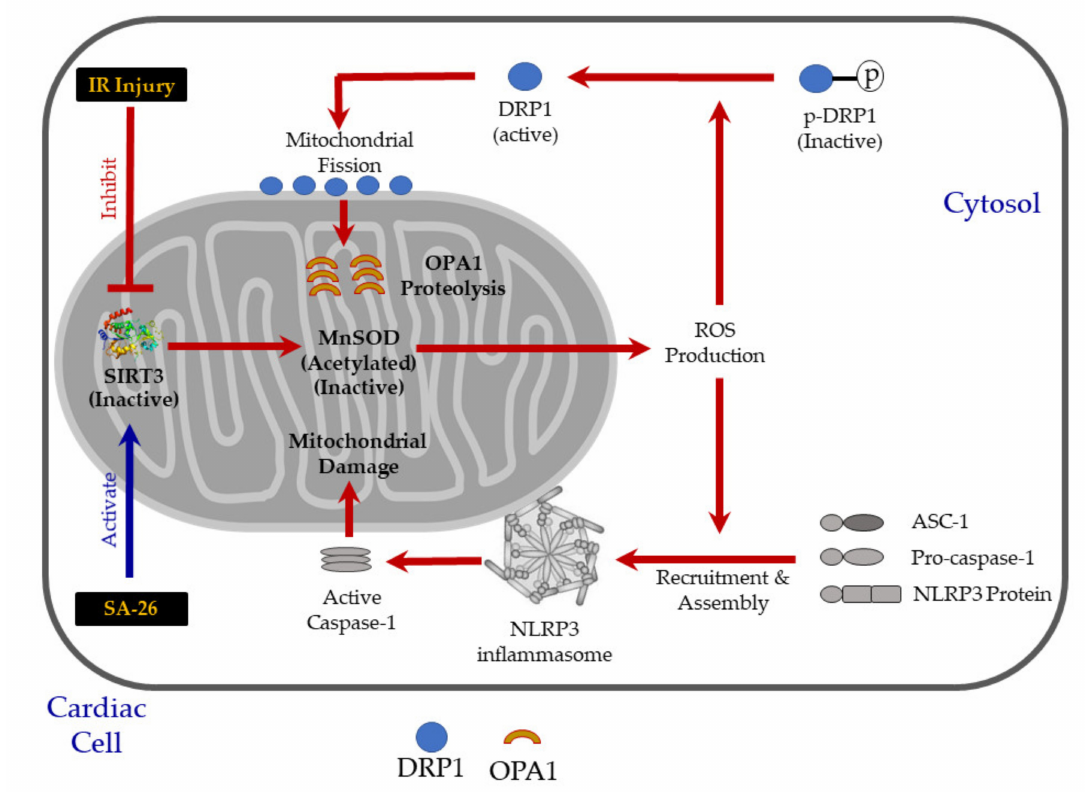
Figure 6. Conceptual illustration showing the potential cardioprotective role of the EDP surrogate SA-26 against IR injury. Hearts subjected to IR injury showed decreased SIRT3 activity and increased acetylation of MnSOD, suggesting diminished antioxidant capacity. Accordingly, the reactive oxygen species (ROS) burst from damaged mitochondria triggers excessive activation and recruitment of DRP1 on the mitochondrial outer membrane, inducing OPA1 proteolysis which impairs mitochondrial fusion, perturbs cristae structure, and prompts mitochondrial fragmentation. Furthermore, the excessive ROS production from the damaged mitochondria activates the assembly of NLRP3 inflammasome on mitochondrial membrane leading to the activation of caspase-1 which in turn, aggravates mitochondrial damage. Perfusion of hearts with SA-26 during the reperfusion period ameliorates IR injury by maintaining mitochondrial integrity and function. Hearts perfused with SA-26 showed improved SIRT3 activity, enhanced antioxidant capacity and limited oxidative injury. This e ff ect was associated with the inhibition of the assembly and mitochondrial translocation of the detrimental NLRP3 inflammasome and consequently improved postischemic functional